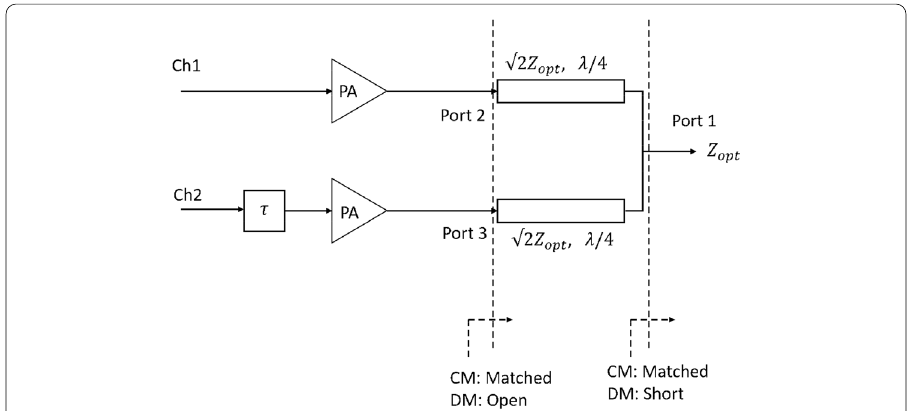
Fig. 7 Two-channel lossless power combiner based on T-junction with quarter wavelength transmission